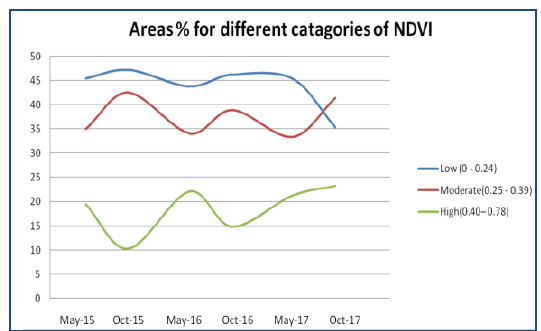
Fig.8. NDVI Change Detection of the Study Area.